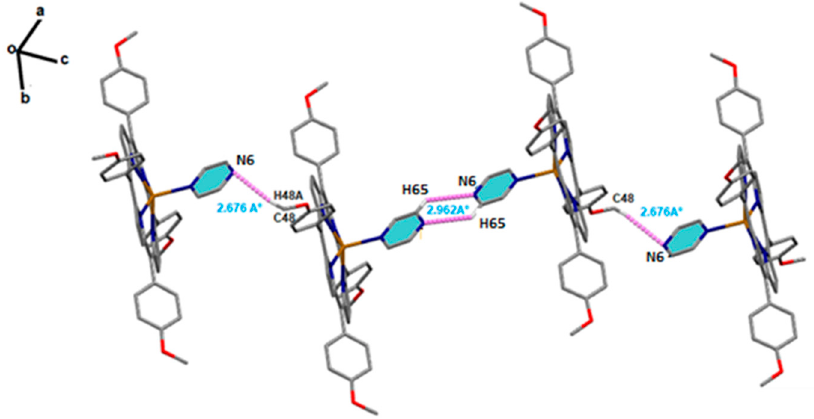
Figure 3. Schematic representation of C-H···N H-bonds between the two pyrazine axial ligands of two adjacent complexes ( 1 ). Intermolecular interaction contacts are shown as purple dashed lines.